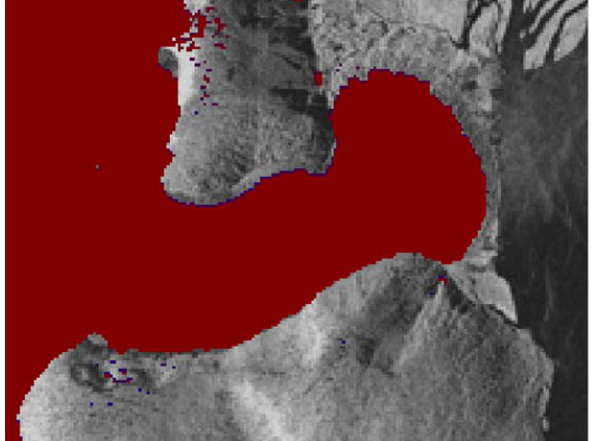
Figure 6. The glacier surface classification result (red colour) based on optical and thermal data plotted on the geo-coded gray scale SAR scene with 3m resolution.